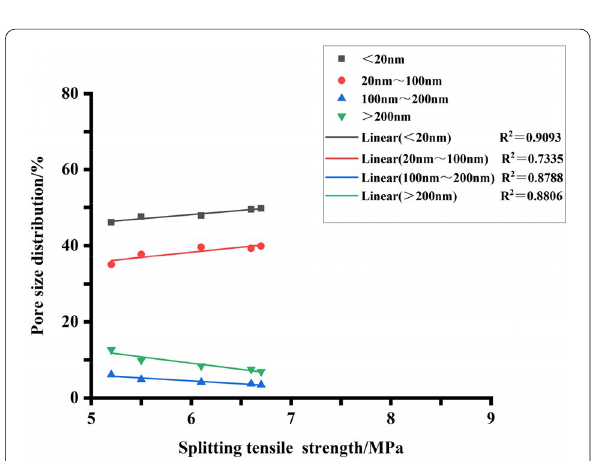
Fig. 28 Relationship between critical pore diameter and splitting tensile